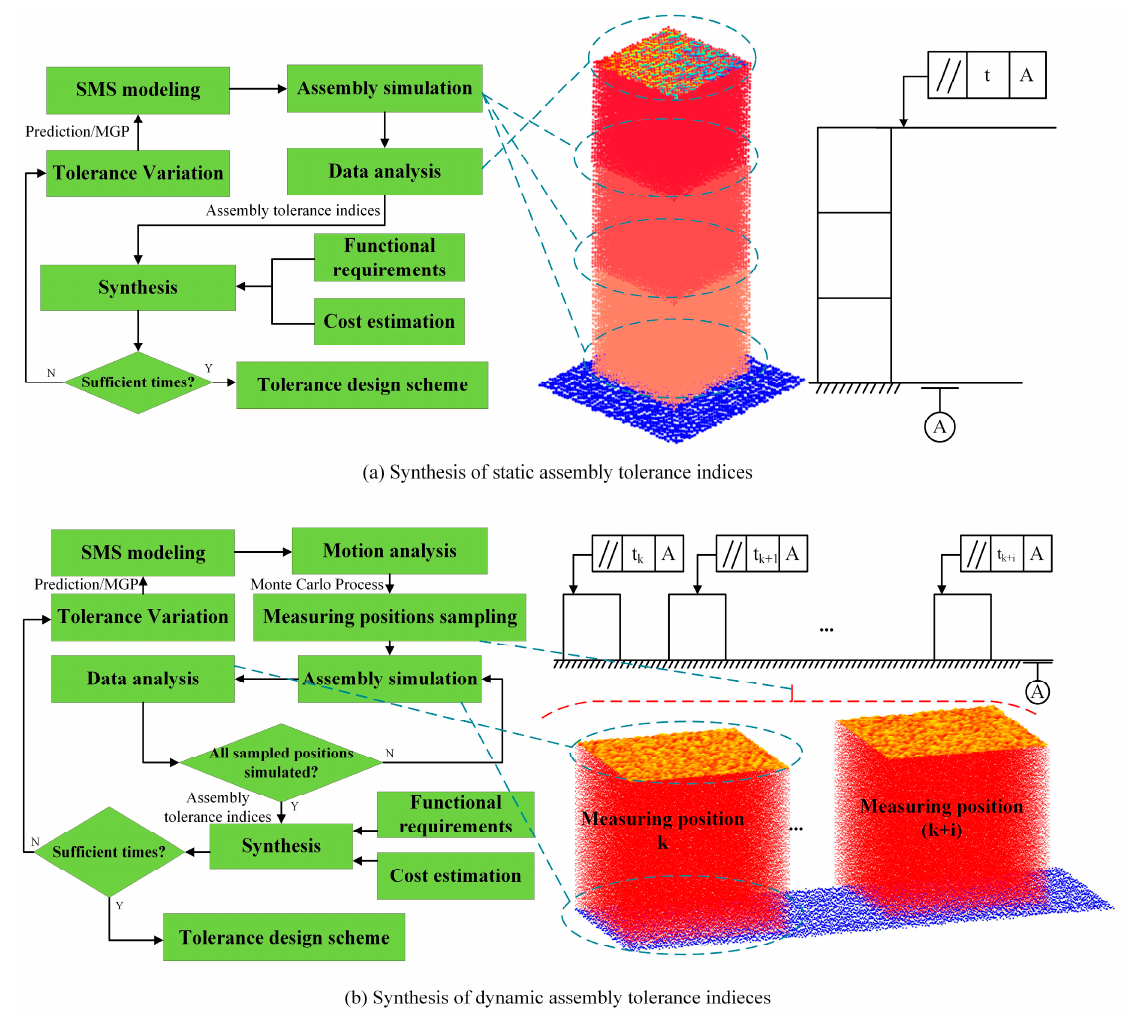
Figure 4. Synthesis of static and dynamic assembly tolerance indices based on assembly simulation.